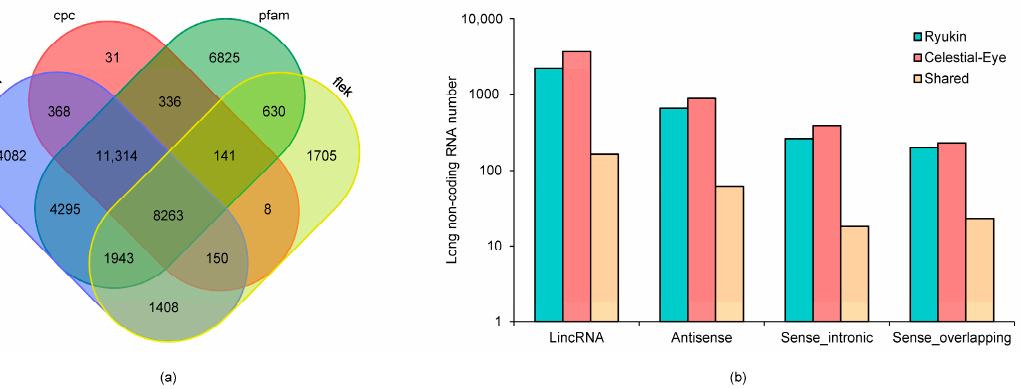
Figure 5. Long non-coding RNAs identified in Ryukin and Celestial-Eye goldfish. ( a ): LncRNAs predicted by different methods; ( b ) genomic distribution of lncRNA.